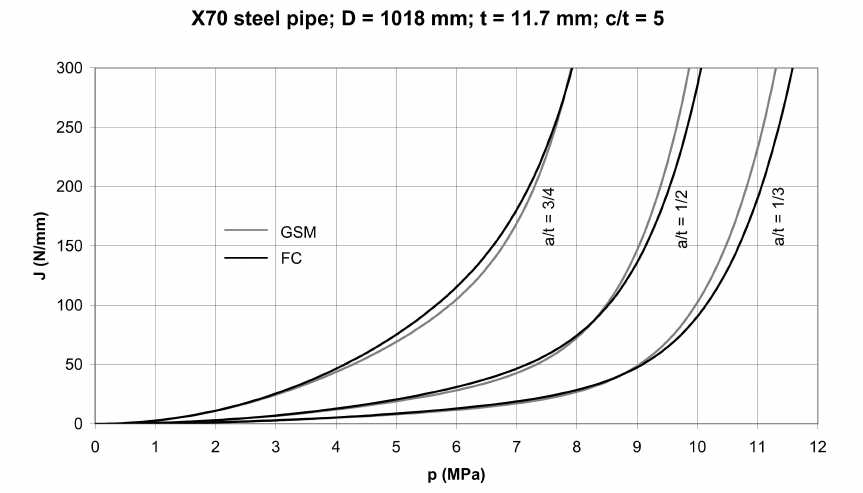
Figure 20. The J – p dependences for the X70 steel pipe segment with part-through cracks of various relative depths and of relative surface length 2c/t =